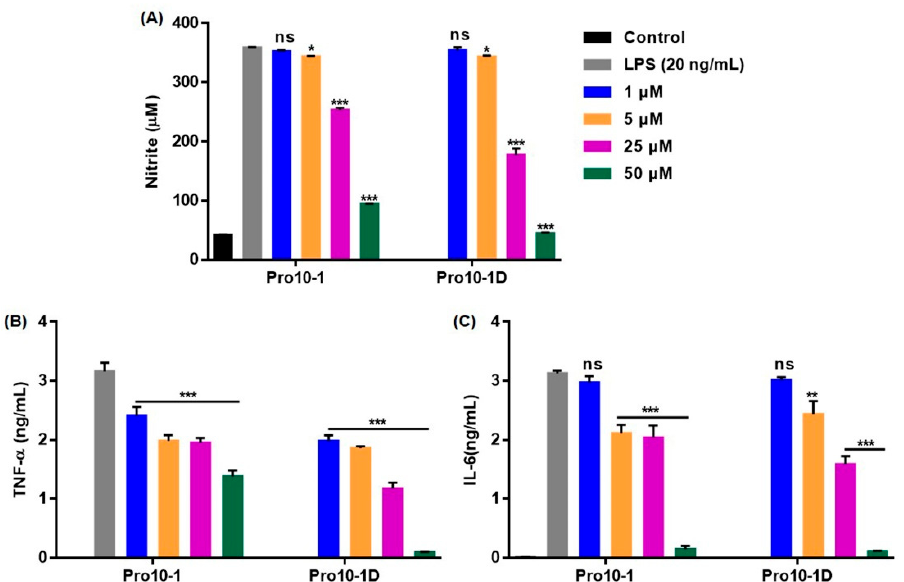
Figure 9. Pro10-1D modulates lipopolysaccharide (LPS)-induced inflammatory response in RAW264.7 cells. ( A ) Graphical data signify the dose-dependent inhibition of nitrite production and ( B , C ) expression of inflammatory cytokines (TNF- α and IL-6) in RAW264.7 cells incubated with peptides (0–50 µM) and then challenged with LPS (20 ng/mL) for 16 h. Data are expressed as the mean ± SEM of three independent experiments and are statistically significant, based on one-way ANOVA ( Tukey’s post hoc test , * p < 0.05, ** p < 0.01, and *** p < 0.001; ns, not significant).